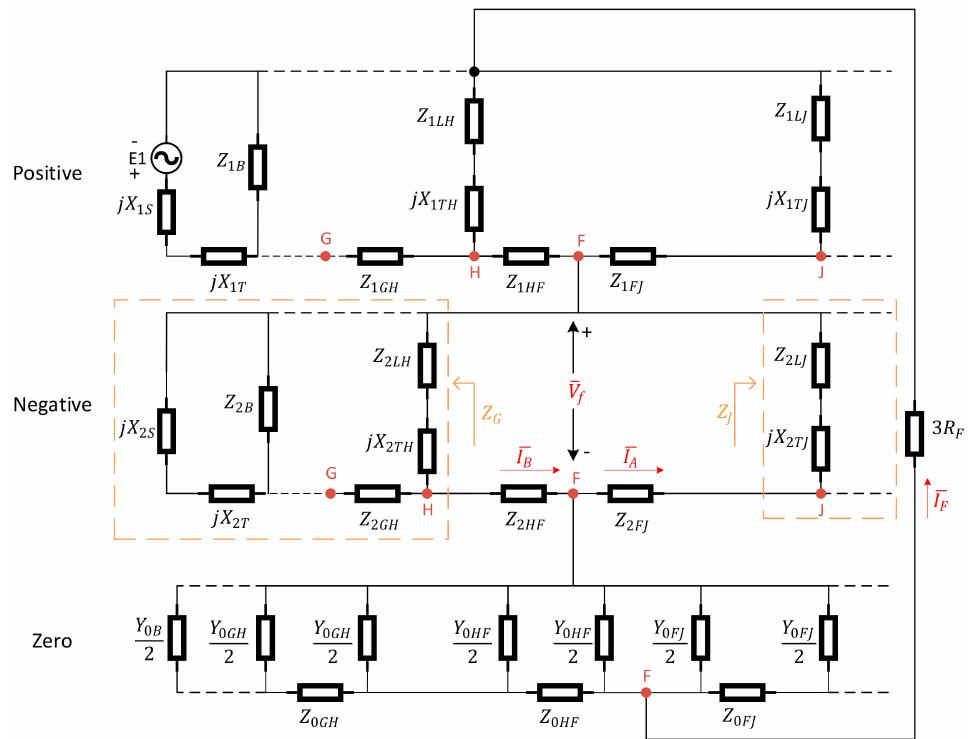
Figure 6. Sequence networks and interconnections for a phase-to-ground fault in the system of Figure 2.